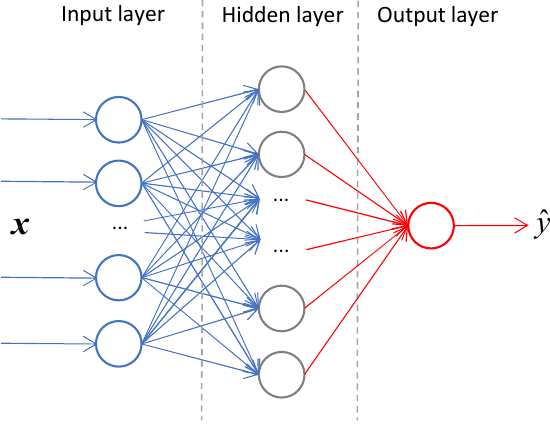
Figure 1. Artificial neural network.